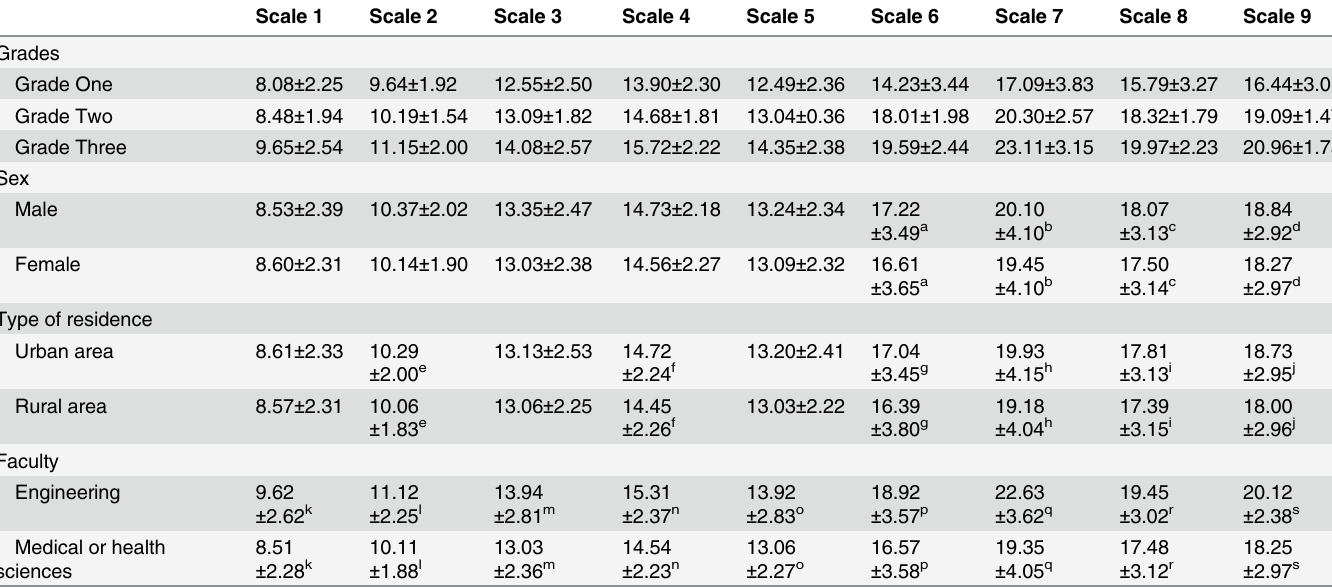
Table 2. Average Score of Each Scale in Different Grades, Sex, Type of Residence, and Faculties (M ±